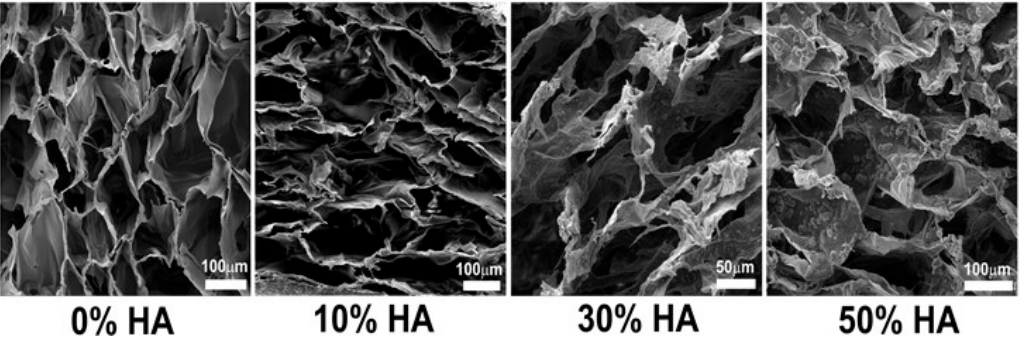
Figure 1. SEM micrographs of cross section of different chitosan-hydroxyapatite (Cht-HA) scaffolds. Pure chitosan scaffold shows smooth surface, while small crystals at the beginning of their growth were found in scaffold with 10% of HA. Petal-like hydroxyapatite crystals are formed in 30% HA scaffold, while cauliflower-like HA particles are homogeneously distributed in scaffold with 50% of HA.